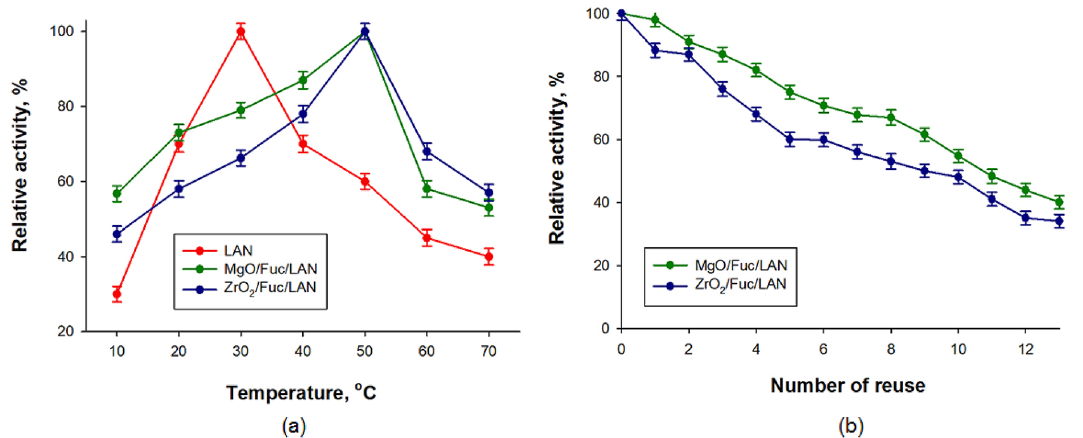
Figure 6. Influence of temperature ( a ) and repeated use on the catalytic activity of free and immobilized lipase ( b